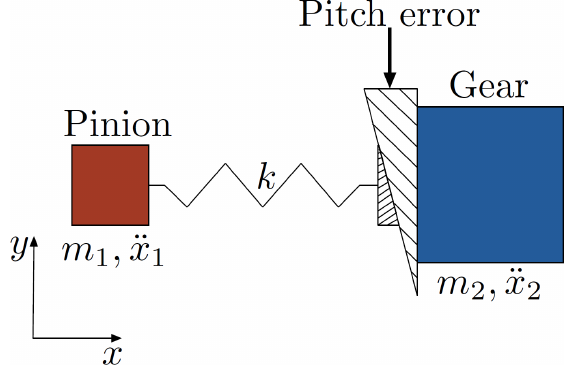
Figure 3. Tuplin’s proposed dynamic model, as described in